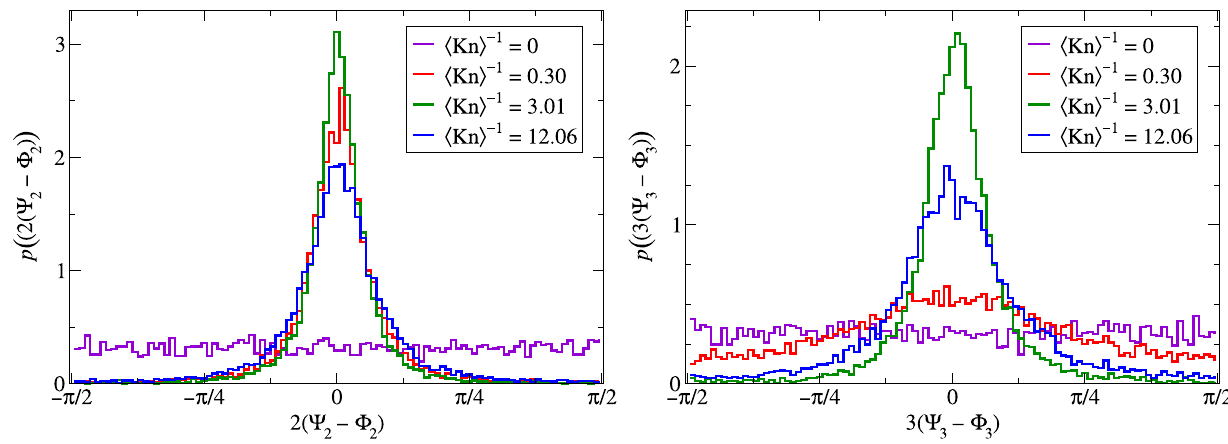
Fig. 11 Probability distribution of p ( 2 ((cid:5) 2 − (cid:4) 2 )) (left) and p ( 3 ((cid:5) 3 − (cid:4) 3 )) (right) at b = 0 fm for different values of (cid:3) Kn (cid:4) − 1